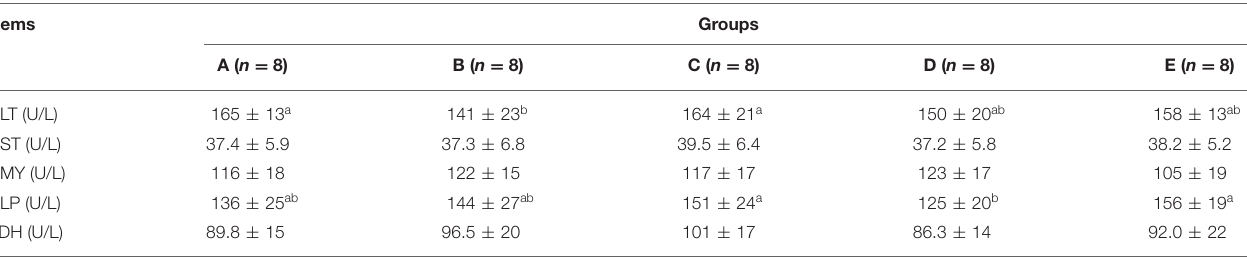
TABLE 6 | Effects of different calcium sources on enzymes in plasma of weaned